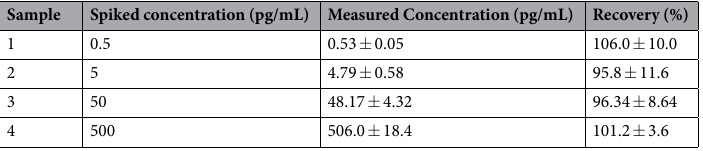
Table 2. Recoveries of p24 antigen spiked into HIV negative plasma samples using SNIA.